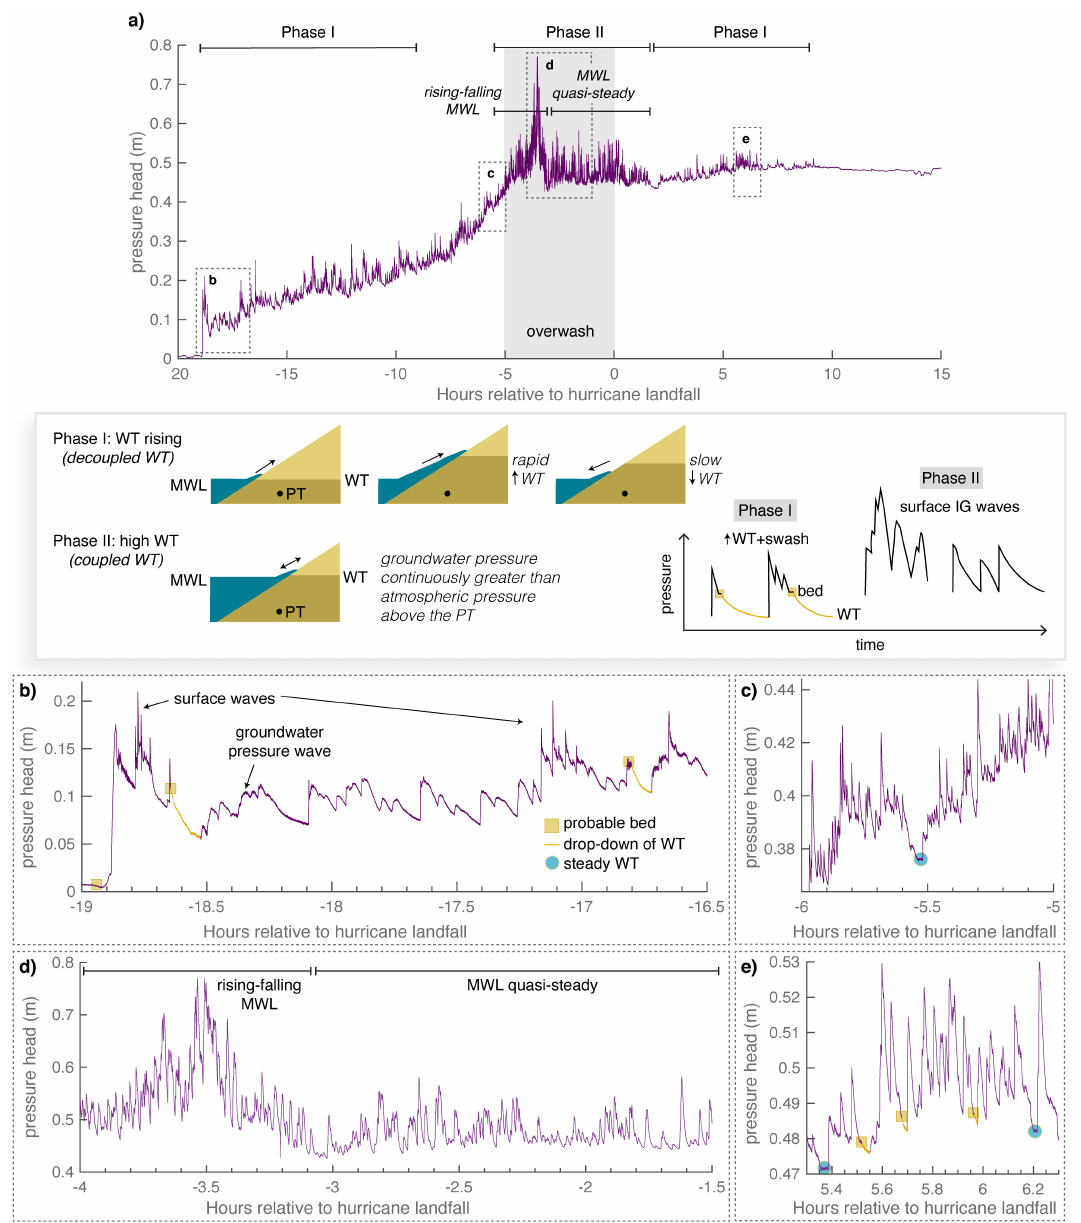
Figure 4. ( a ) pressure head in the backshore at Matagorda Peninsula (PT-1) for the time period when wave-like signals were observed in the sea-swell and IG frequency range ( − 18.8 to 9 h). The schematics show how the pressure time series are categorized within two “phases”, corresponding to the degree to which the capillary fringe influences the pressure head of surface wave and swash signals due to a decoupling of the groundwater table (WT) and sand bed. Subsets of ( a ) are shown in ( b , e ) for Phase I, when the mean water level (MWL), WT, and sand bed are rising but at different rates and with varying time-evolution; ( c ) a transitional period that depicts the last WT pressure signal prior to Phase II; and ( d ) Phase II, when the sand bed is fully coupled to the WT. During Phase II, pressure head fluctuations are assumed to be hydrostatic and representative of surface waves. See text for additional